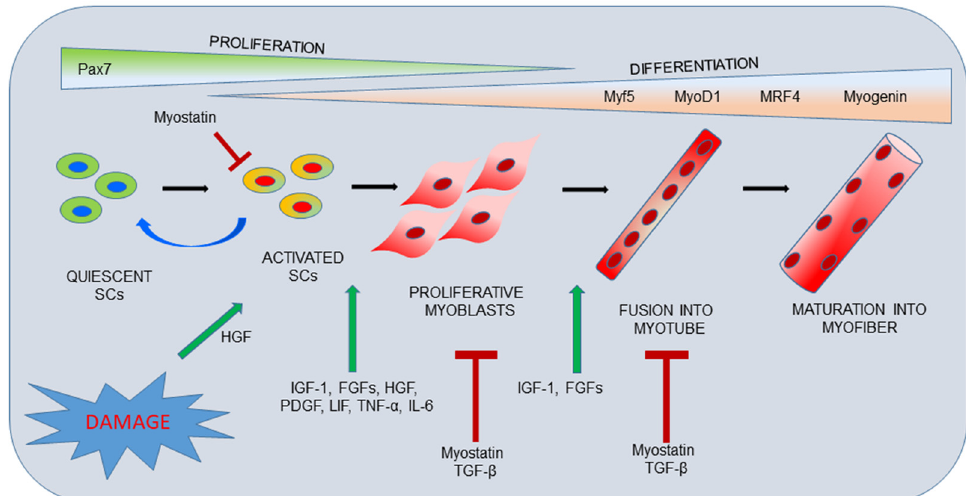
Figure 1. Skeletal muscle regeneration. Activation and differentiation processes of SCs are finely controlled by a genetic cascade involving Pax7 and the myogenic regulatory factors (Myf5, MyoD1, MRF4 and Myogenin), which drive every step of skeletal muscle regeneration, up to the formation of new muscle fibers. Activated SCs can retain Pax7 expression and return to a quiescent state to contribute to the replenishment of the SC pool for future muscle regeneration. Specific growth factors modulate SC activity and they are released from a number of tissues after tissue damage, and they are responsible to modulate SC proliferation and differentiation.